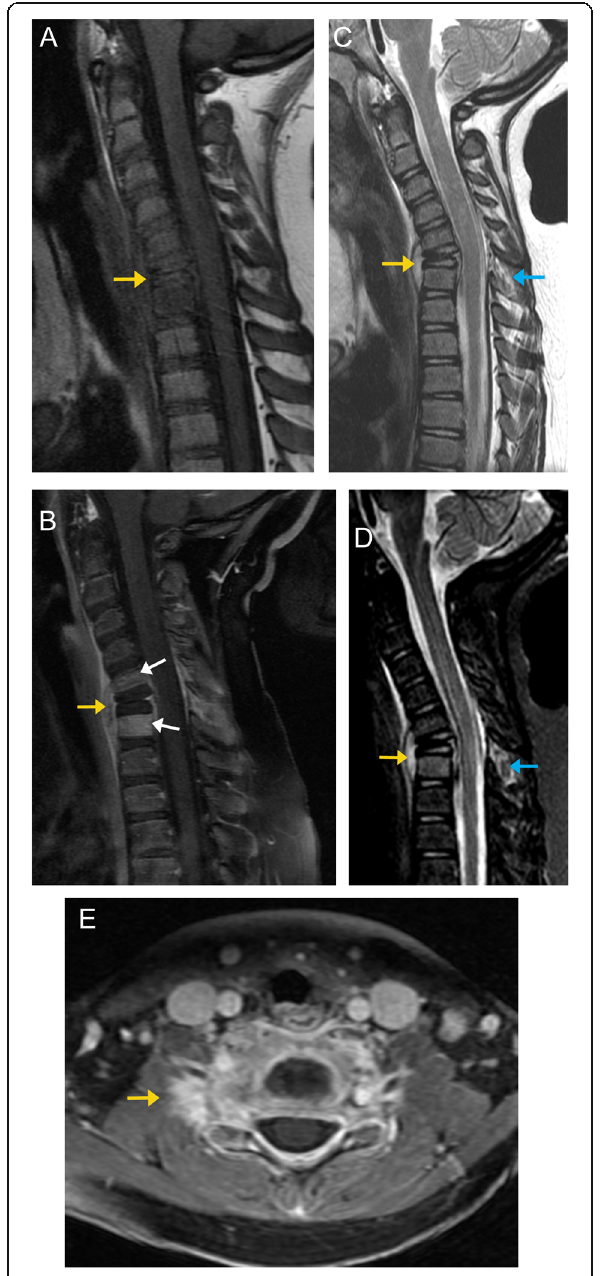
Fig. 12 Eosinophilic granuloma. Sagittal T1 image ( a ) demonstrates suggestion of vertebral plana (orange arrow), however difficult to detect due to the lesion appearing isointense to pediatric marrow on T1. Sagittal T1 post-contrast MR image ( b ) shows an enhancing mass (orange arrows) with diffuse marrow infiltration of C5 and C7 (white arrows), and C6 pathologic vertebral collapse, sparing the adjacent vertebral endplates and discs. Sagittal T2 ( c ) and T2 fat -saturated ( d ) images demonstrate the lesion as a heterogeneously hyperintense soft tissue mass. There is edema of the posterior interspinous soft tissue, more evident on fat suppressed image (blue arrows). Axial T1 post contrast image ( e ) demonstrates asymmetric enhancement surrounding the right facets (orange